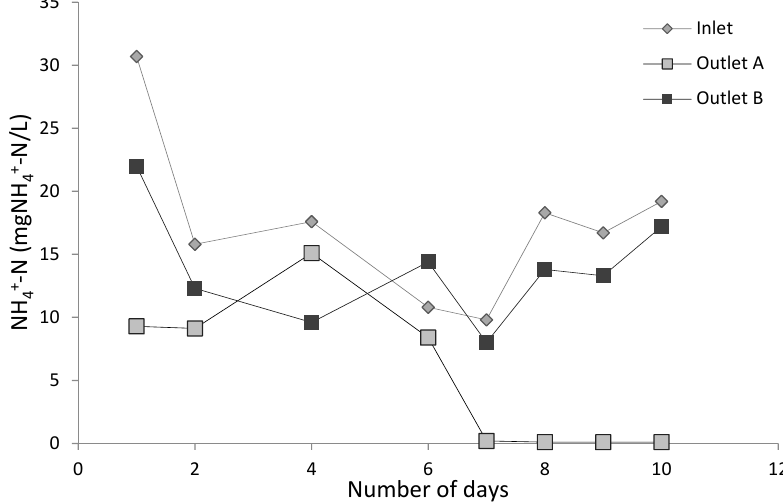
Figure 5. Effluent ammonia concentrations from control and aerated CW in Site A on resuming operation after 5 months of being offline.